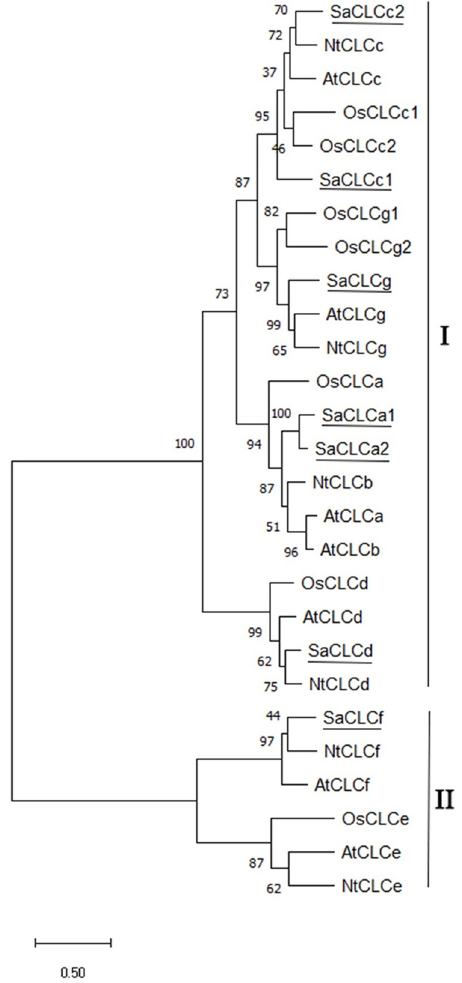
Figure 7. Phylogenetic tree of CLC family proteins of Arabidopsis thaliana , Oryza sativa , Nicotiana tabacum , and Suaeda altissima . All protein sequences were taken from the Protein Database (NCBI). Subgroup I is the “eukaryotic” branch, and subgroup II is the “prokaryotic” branch: AtCLCa (NP_198905.1), AtCLCb (NP_189353.1), AtCLCc (NP_199800.1), AtCLCd (NP_197996.1), AtCLCe